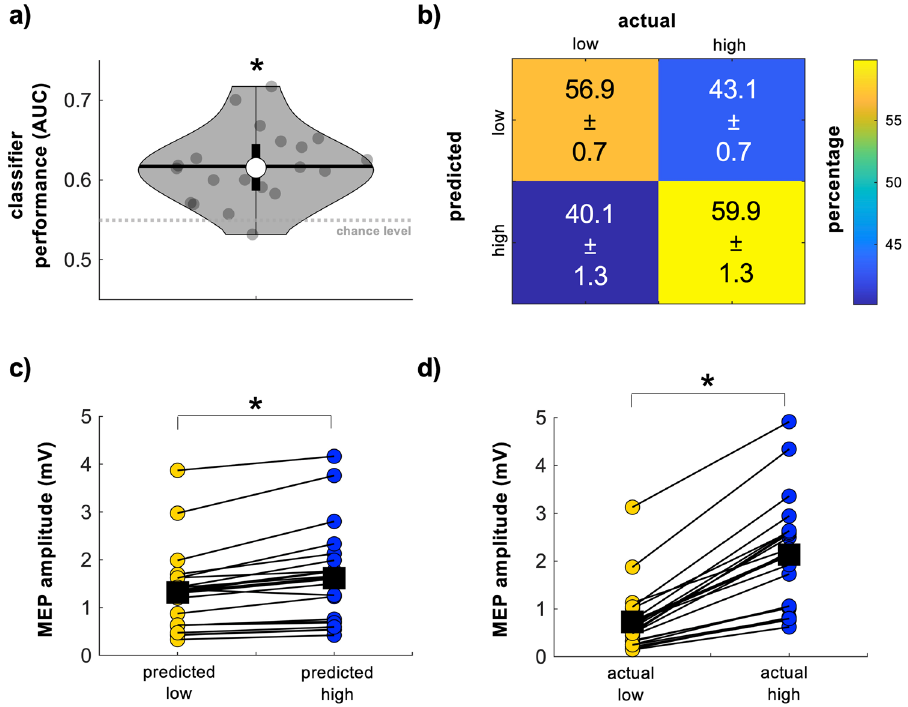
Figure 2. Personalized classification of low and high M1 excitability states. ( a ) AUC values reflecting classification performance. Classifiers were trained at the individual participant level using personalized power spectral features obtained from EEG data immediately preceding TMS (i.e., between 0.505 and 0.005 s before TMS). These personalized classifiers performed significantly above chance in 16 of 20 participants and at the group level. The grey dashed line indicates the empirical chance level for a two-class classification problem (here, 0.55). Grey dots = individual participant AUC values, thick whisker = interquartile range, thin whisker = full range, white dot = group median, black horizontal line = group mean, grey dashed line = empirical chance level. ( b ) Group-level confusion matrix describing the percentage of accurate and inaccurate classifications of M1 excitability states. Note that the percentage of true low (upper left) and true high (lower right) classifications exceed the percentage of false low (upper right) and false high (lower left) classifications. Error estimates are SEM. ( c ) MEP amplitudes elicited during classifier-predicted low (yellow dots) and classifier-predicted high (blue dots) M1 excitability states. MEPs were significantly larger during classifier-predicted high excitability states than classifier-predicted low excitability states in 18 of 20 participants (colored dots) and at the group level (black squares). ( d ) MEP amplitudes elicited during true low (yellow dots) and true high (blue dots) M1 excitability states. As expected, MEPs were significantly larger during true high excitability states than true low excitability states in all participants (colored dots) and at the group level (black squares). * Indicates group-level statistical